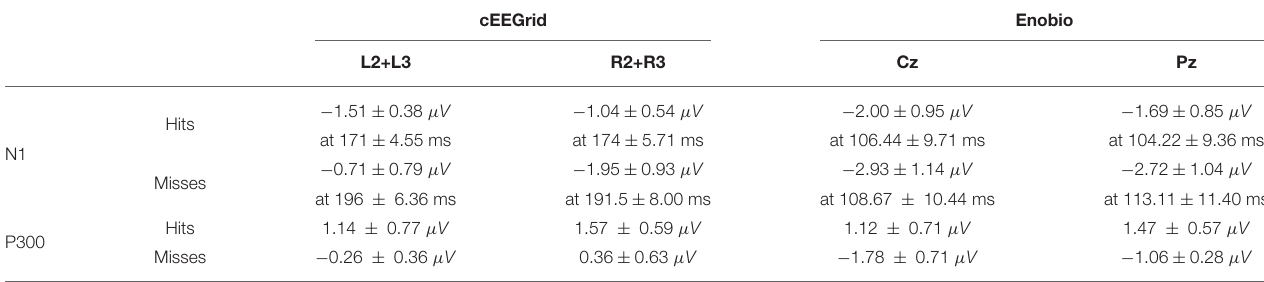
TABLE 2 | Average ± SEM amplitude of the N1 (top part) and P300 (bottom port) recorded with the cEEGrid (left hand-side) around the left ear (first column–an average of L2 and L3 electrodes) and the right ear (second column–an average of R2 and R3 electrodes), and with the solid gel-based Enobio at the Cz (third column) and Pz (last column) electrodes.